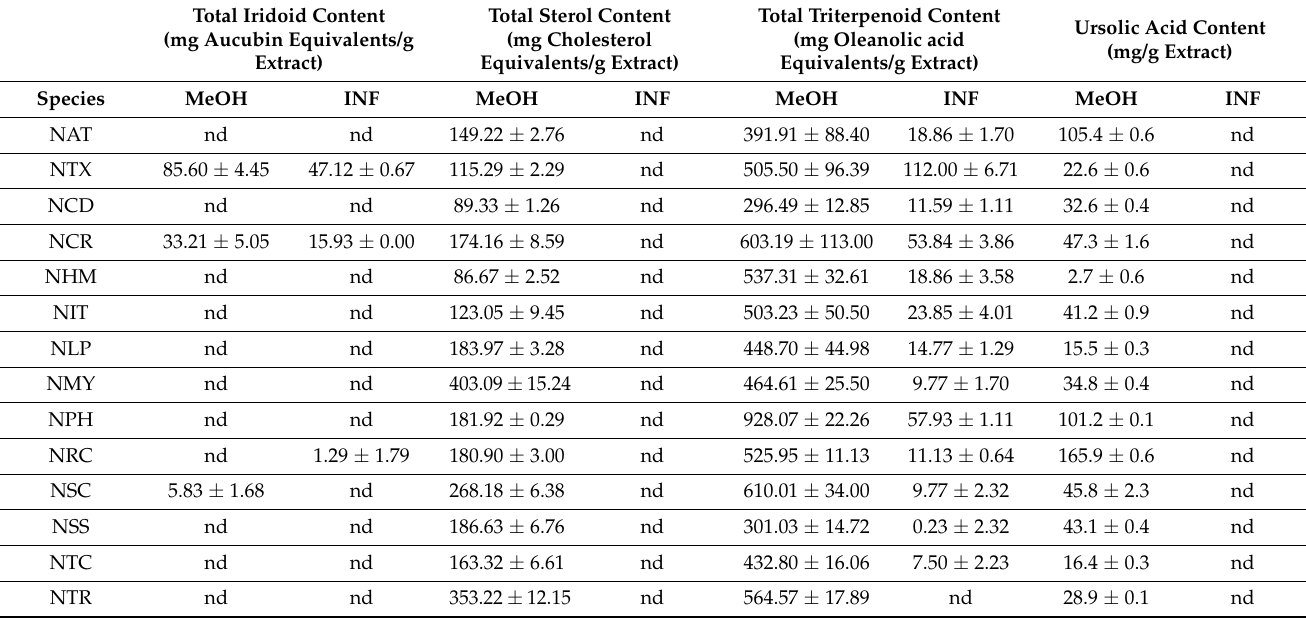
Table 1. Total triterpenoid, steroid, iridoid and ursolic acid contents of Nepeta extracts. Total Iridoid Content (mg Aucubin Equivalents/g